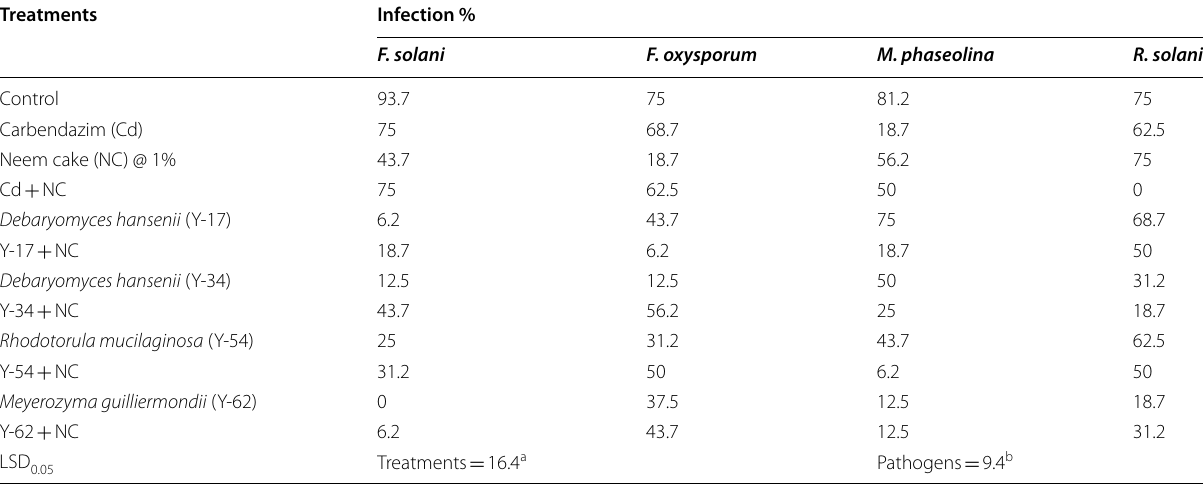
a Mean values in column showing differences greater than LSD values are significantly different at p < 0.05 b Mean values in rows showing differences greater than LSD values are significantly different at p < 0.05